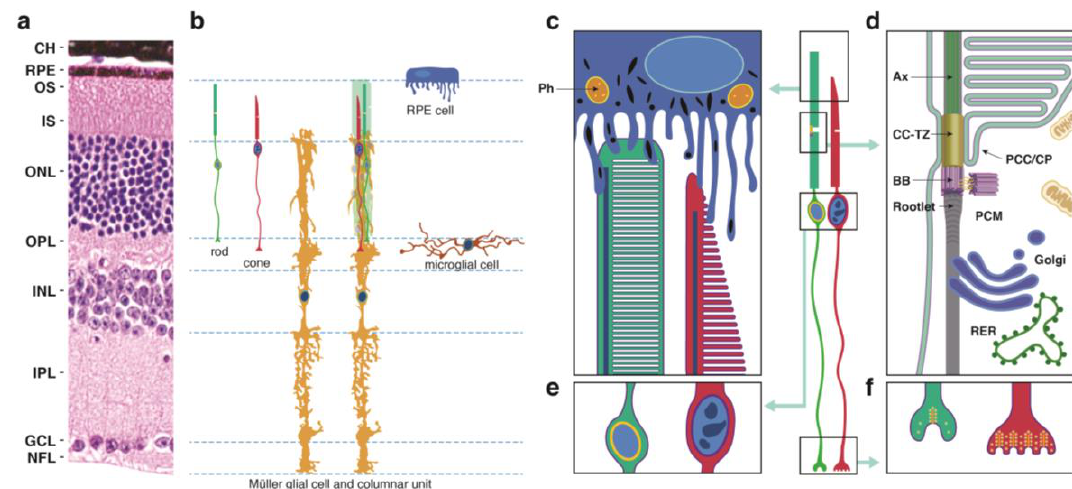
Figure 1. Retinal tissue organization emphasizing cell types and subcellular structures that may be sites of pathological processes in mouse models of photoreceptor (PR) cell loss. ( a ) A radial section of the posterior eye stained with hematoxylin and eosin shows the layered structure of the retina. CH, choroid; RPE, retinal pigment epithelium; IS, inner segment; OS, outer segment; ONL, outer nuclear layer; OPL, outer plexiform layer; INL, inner nuclear layer; IPL, inner plexiform layer; GCL, ganglion cell layer; NFL, nerve fiber layer. ( b ) Two PR cell types (rods and cones) and additional cell types that may be the target of processes implicated in PR cell loss. Dashed lines indicate alignment with retinal layers in ( a ). A columnar unit consisting of one cone and one Müller cell and roughly 20 rod cells is shown. ( c – f ) Details of PR and RPE cells. ( c ) PR cell OSs contain flattened discs (rod, left) or incomplete discs (cone, right) where the light sensing apparatus is located. OS tips engulfed by RPE cell apical processes are digested in phagolysosomes (Ph). ( d ) The base of the OS, the connecting cilium, and the apical portion of a rod cell IS (adapted with permission from [24]). The axoneme (Ax) and rootlet provide physical stability to the cilium. BB, basal bodies; CC-TZ, connecting cilium-transition zone; PCM, pericentriolar matrix; PCC / CP, periciliary complex / ciliary pocket; RER, rough endoplasmic reticulum. ( e ) The PR cell soma is largely occupied by the nucleus. ( f ) Rod and cone synaptic termini include presynaptic ribbons and associated neurotransmitter vesicles.